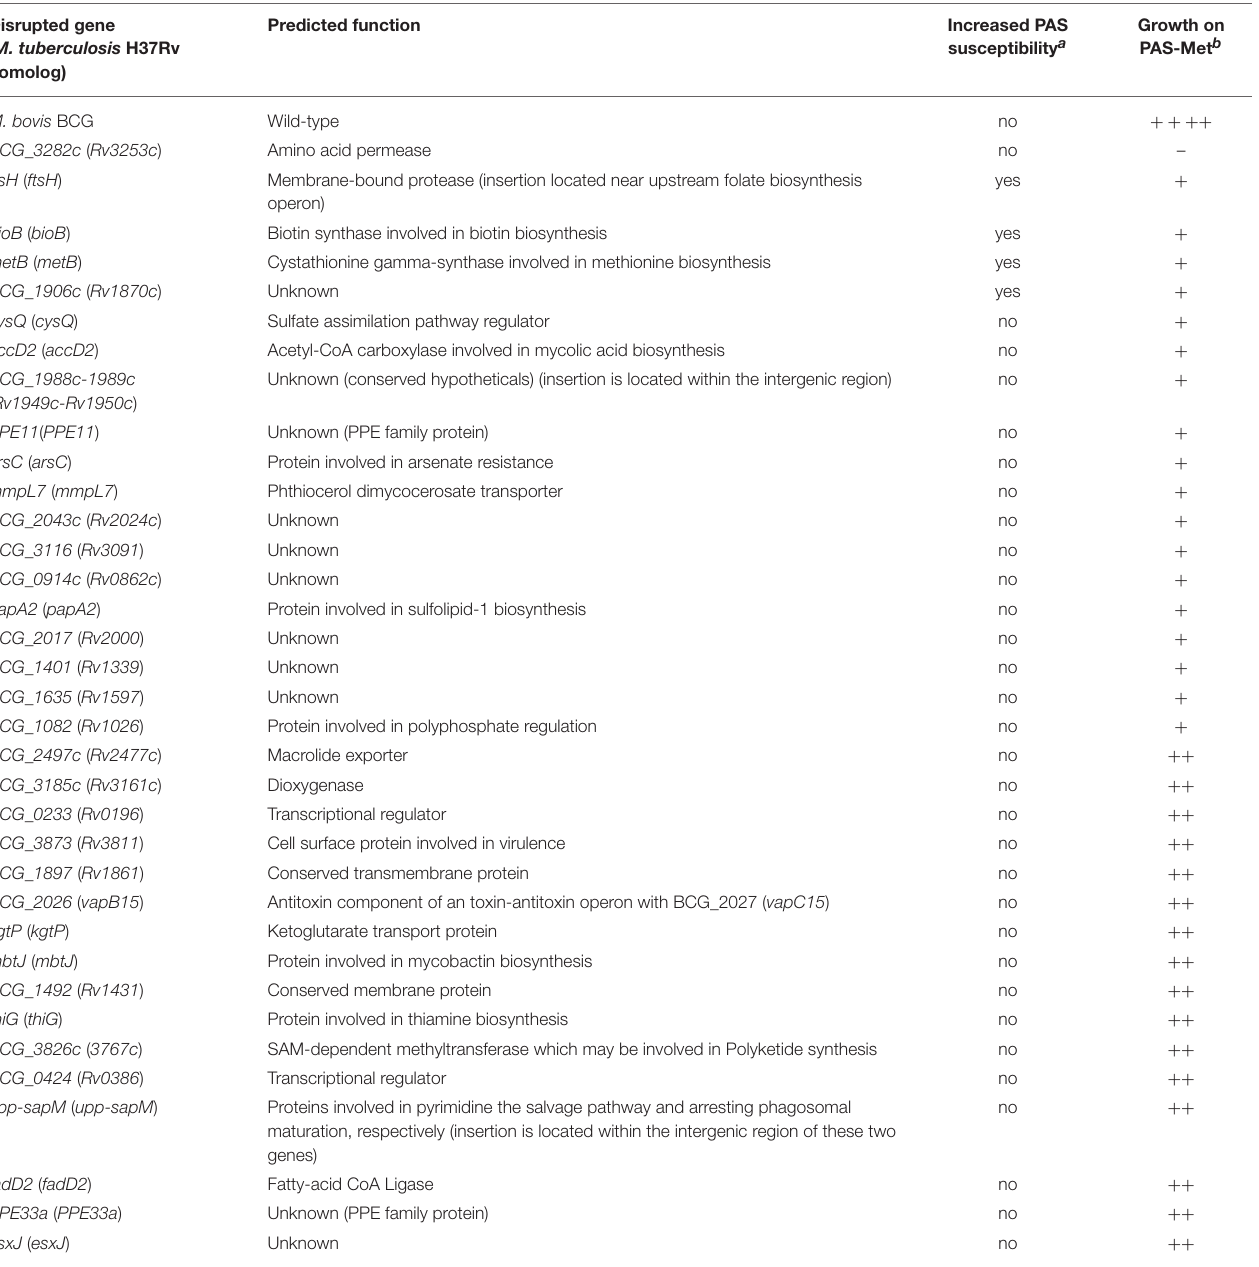
TABLE 2 | Sequence-validated gene insertions that affect PAS susceptibility in the presence or absence of antagonistic concentrations of methionine. Disrupted gene Predicted ( M. tuberculosis H37Rv homolog)